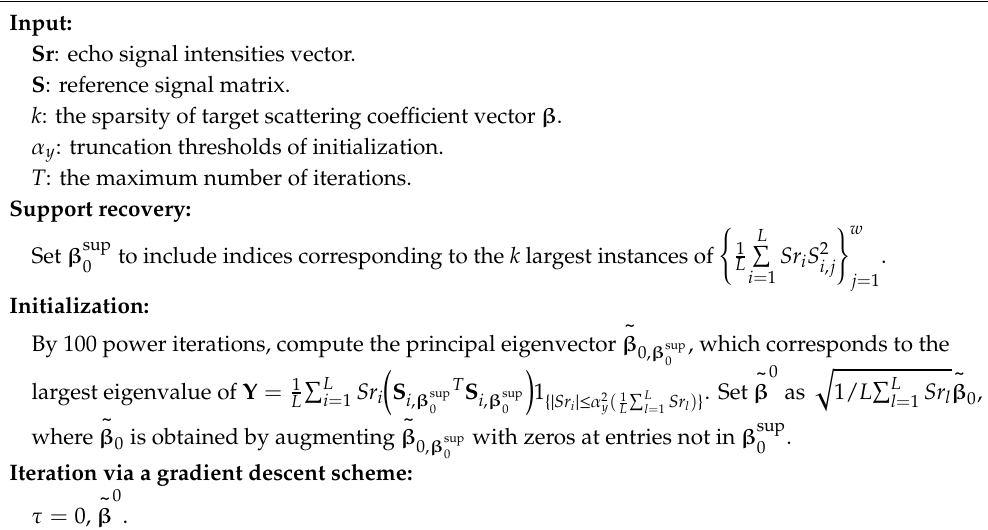
Algorithm 1: Sparse Wirtinger Flow algorithm with Optimal